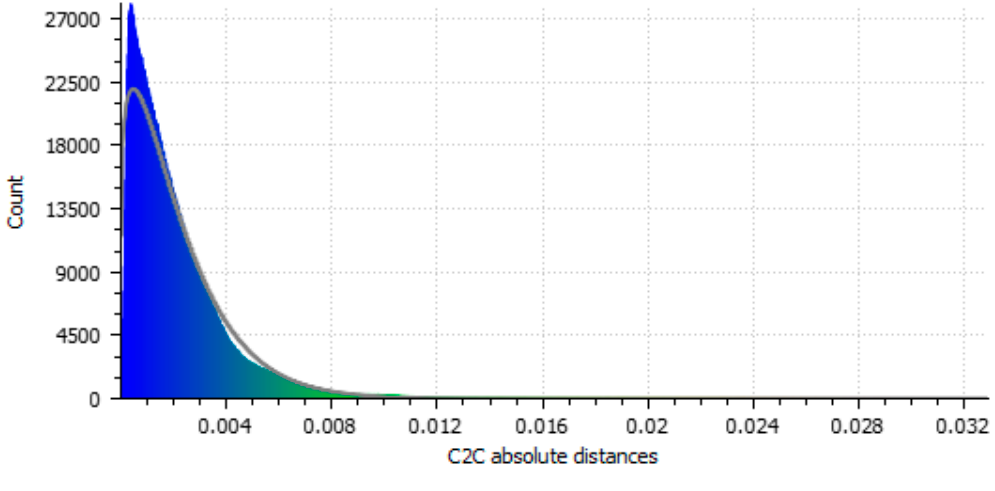
Figure 14. Measured differences between model generated by the camera and Huawei phone, ( top )—visualization of differences projected on model, ( bottom )—distribution of measured differences. Table 5. Weibull parameters observed from each model comparison for Distressed Section